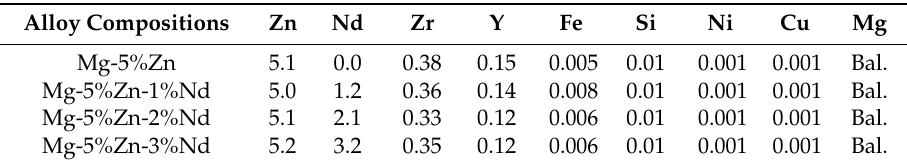
Table 1. Chemical composition of the tested alloys (in wt